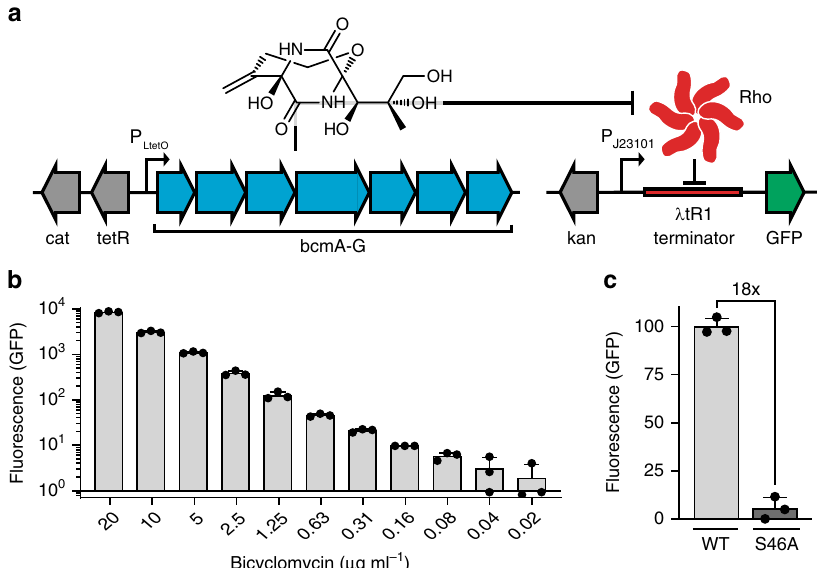
Fig. 1 A genetically encoded sensor for BCM bioactivity. a Schematic representation of plasmids for BCM production and BCM-dependent GFP expression, featuring a constitutive promoter interrupted by the Rho-dependent λ tR1 terminator. BCM biosynthesis from a plasmid carrying an anhydrotetracycline (aTC) inducible promoter results in GFP production by alleviating Rho-dependent transcriptional termination of GFP on reporter plasmid pREP.1. b GFP reporter pREP.1 response across a wide range of BCM concentrations. c GFP production upon induction of the P. aeruginosa wild-type (WT) or inactivated (S46A) BCM operon. All data shown as mean±s.d.; n = 3 biological replicates. Source data underlying b , c are available as a Source Data fi